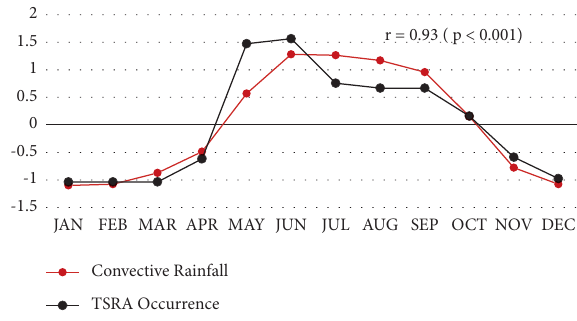
Figure 14: The correlation of standardized monthly convective rainfall based on ERA5 and observed station TSRA occurrence datasets, averaged over longitudes 96 ° E-97 ° E and latitudes 16 ° N- 17 ° N for the period of